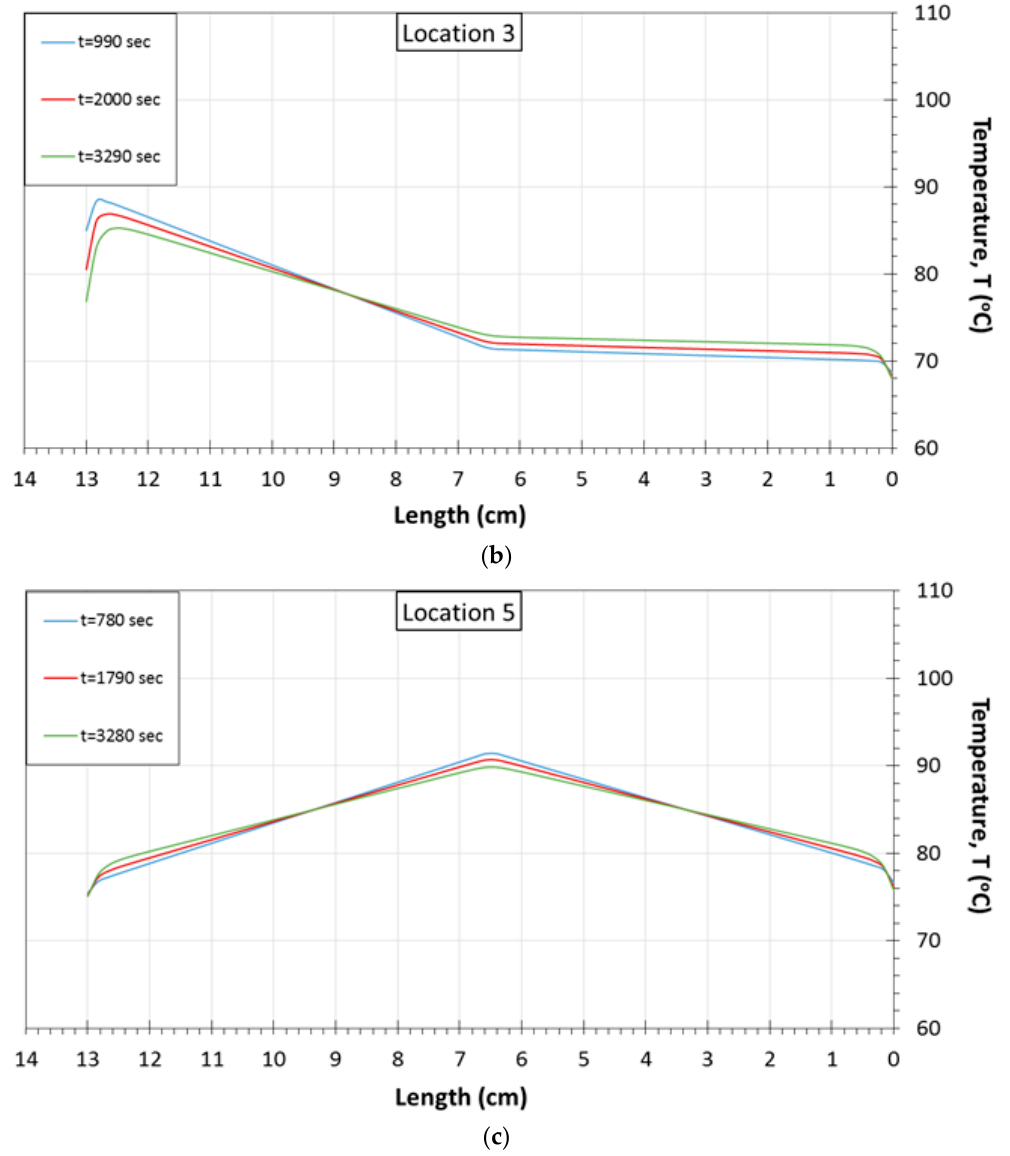
Figure 7. Temperature distribution across virtual lines of the 7th layer at different building times for thermocouple locations: ( a ) 1; ( b ) 3; ( c ) 5.